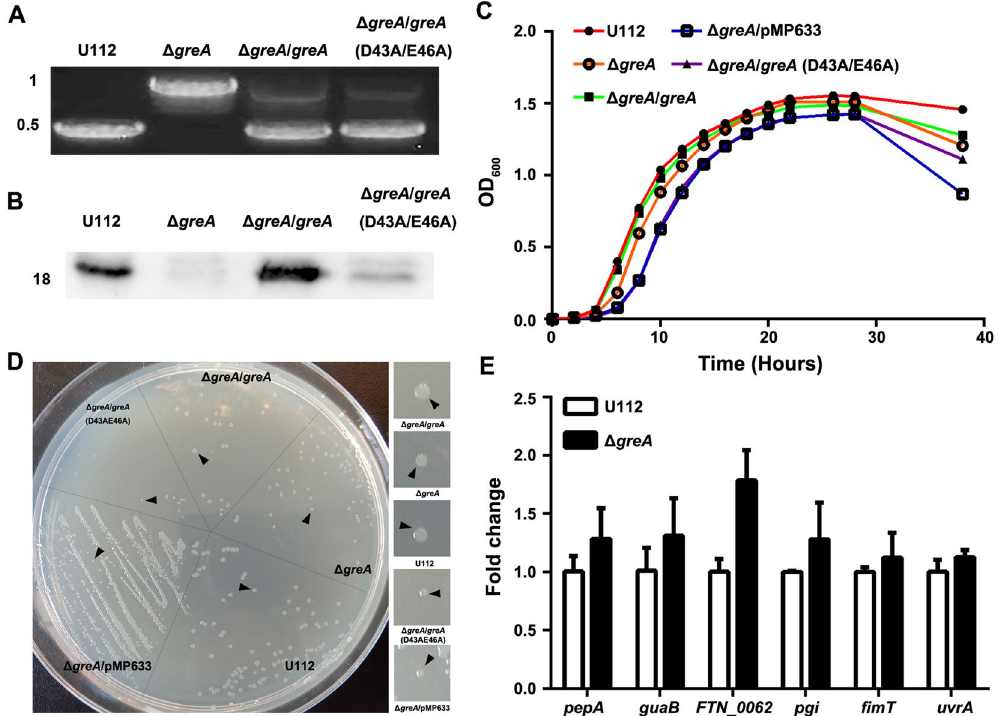
Figure 2. Contribution of GreA to the growth of F. novicida . ( A ) Deletion of greA gene in F. novicida strain U112 was confirmed with PCR using primer pair Pr0023/Pr0024. The images were acquired by the gel imaging system (LIUYI). Sizes of molecular markers are indicated at the left in kbp. ( B ) Loss of GreA protein in F. novicida was detected with western blotting using a mouse polyclonal antibody raised against recombinant GreA protein. The image was acquired by the automatic chemiluminescence image analysis system (Tanon). Size of the protein is indicated at the left in kDa. ( C ) Growth kinetics of wild-type strain U112 and its derivatives in TSB. The values represent the means ± SD (n = 3) from one of the three independent experiments. ( D ) Growth of wild-type strain U112 and its derivatives on TSA plates. The image was acquired with the digital camera (Canon, Janpan). ( E ) Transcription of greA locus genes in wild-type strain U112 and the Δ greA mutant. Data are the relative transcription levels of each target gene normalized to that of the 16S rRNA gene. Results are shown as the mean fold changes relative to the wild-type U112 strain ± SD (n = 3) from one of the three independent experiments. Statistical significance was determined with unpaired Student’s t